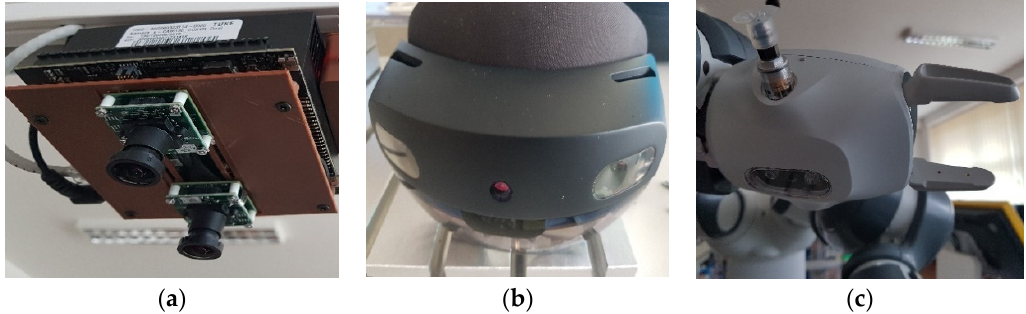
Figure 15. SMART vision system of the collaborative work cell: ( a ) CNN processing unit NVIDIA Xavier AGX; ( b ) Mixed reality device camera; ( c ) Collaborative robot ABB Yumi Vision system integrated into the right hand.